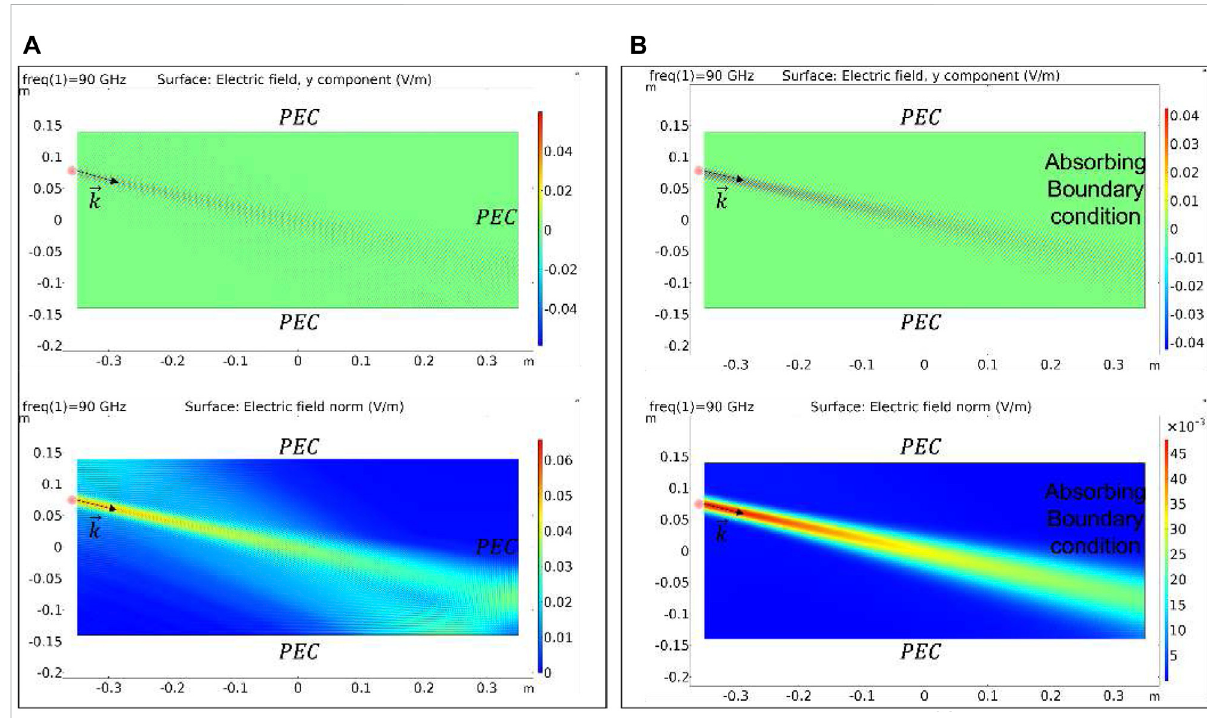
FIGURE 5 Simulated Electric fi eld y component (top) and intensity (bottom) for the all ” Perfect Electric Conductor ” case (A) and in presence of the receiving horn antenna modeled as ” Scattering ” absorbing boundary (B)